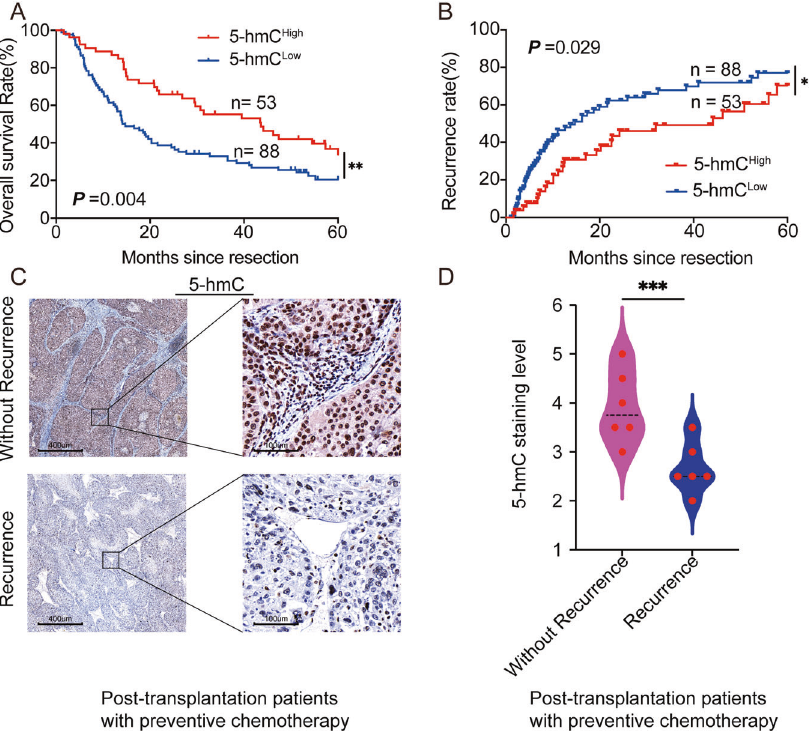
Fig. 7 Loss of 5-hmC contributes to the resistance against oxaliplatin and 5-FU. A , B Kaplan – Meier estimates overall survival and cumulative recurrence rate of advanced recurrent HCC patients after TACE combined oxaliplatin and 5-FU treatment with different levels of